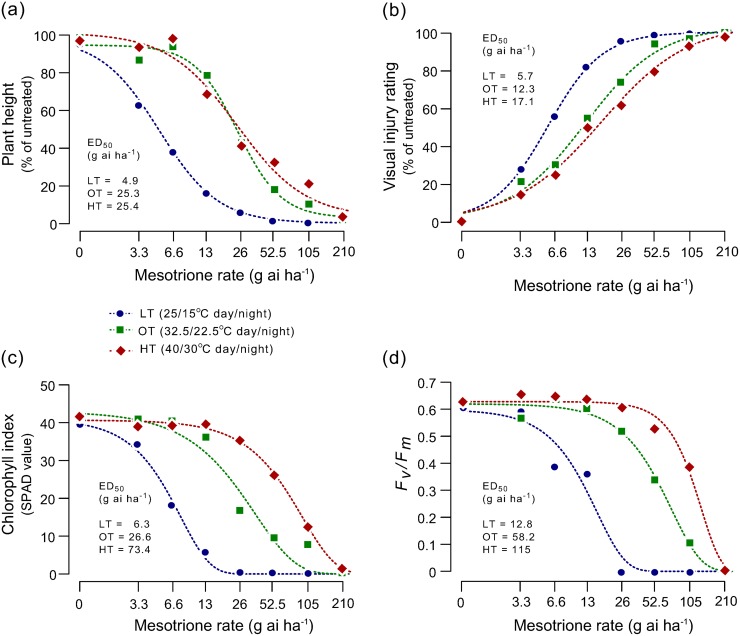
Whole-plant mesotrione dose-response of Palmer amaranth at different temperatures (low temperature, LT, 25/15°C; optimum temperature, OT, 32.5/22.5°C; and high temperature, HT, 40/30°C; 15/9 h day/night) as measured by (a) plant height 3 weeks after treatment (WAT), (b) visual injury 3 WAT, (c) leaf chlorophyll index 2 WAT, and (d) photochemical efficiency of PSII (F
v
/F
m) 2 WAT.Palmer amaranth plants (10 to12 cm tall, 8 to 10 leaf stage) were treated with 0, 3.28, 6.563, 13.125, 26.25, 52.5, 105, and 210 g ai ha-1 mesotrione with 1% v/v crop oil concentrate (COC) and 0.85% w/v ammonium sulphate (AMS). Curves for height and visual injury, and chlorophyll index and F
v
/F
m data were fitted using three parameter log-logistic and Weibull model, respectively, as described by Knezevic et al. (2007).